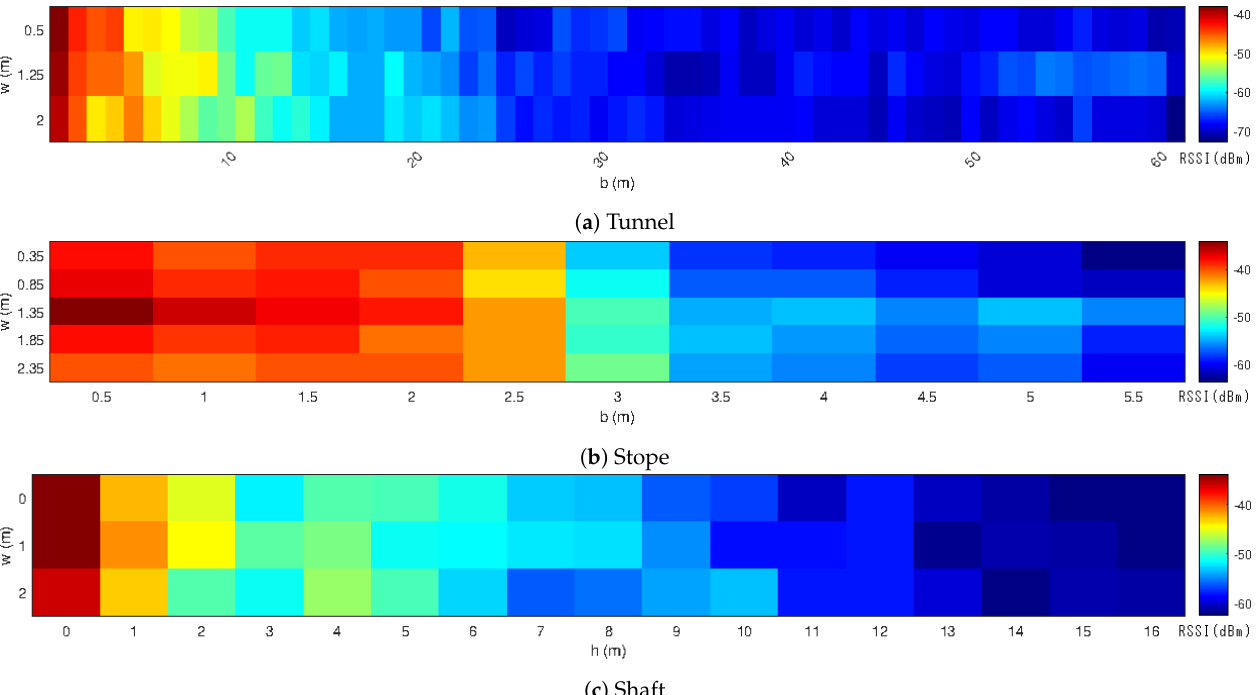
Figure 9. Heat maps visualization of the RSSI values. The heat maps in Figure 9a–c show more detailed RSSI distributions across the width of the measurement areas. The transmitter was placed in the centre of the width w of the measurement area, and the RSSI values are obtained along the w axis every 0.5 m in